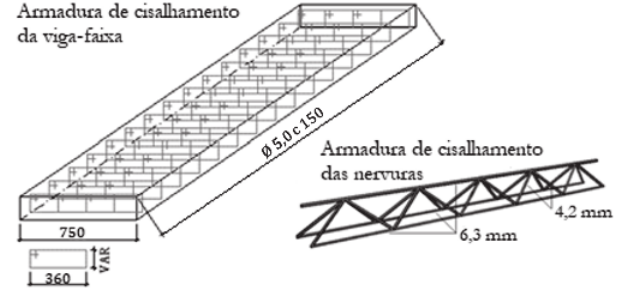
Figura 5 Armaduras de cisalhamento utilizadas nas